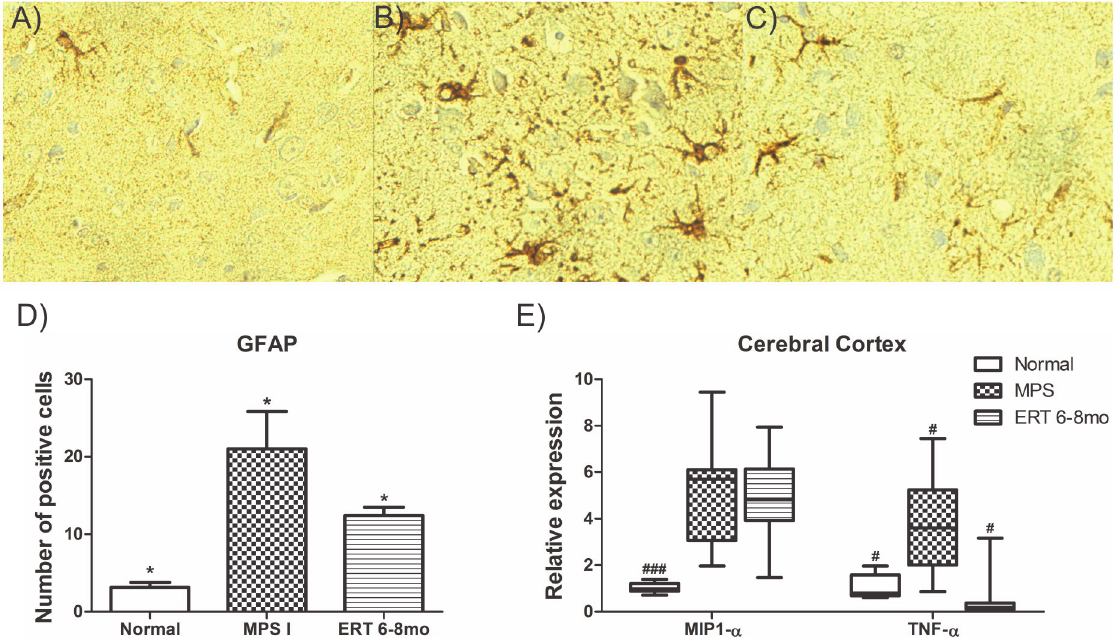
Fig 6. Neuroinflammatory markers. A-C) Representative sections from 8-month normal (A, n = 5), MPS I (B, n = 5) and 6 to 8 months MPS I laronidase treated (C, n = 10) mouse cerebral cortex stained for glial fibrilary acidic protein (GFAP). D) Number of positive cells counted in 5 fields (400× magnification) in mouse cortex at 8 months. * P (cid:1) 0.02. ANOVA and Tukey. E) MIP1- α and TNF- α mRNA expression on cerebral cortex normalized by GAPDH expression. ###P (cid:1) 0.001, #P (cid:1) 0.02 Kruskal-Wallis and Mann-Whitney post hoc